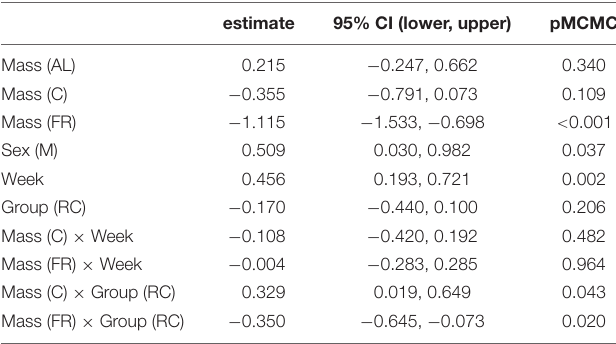
TABLE 1 | The trivariate mixed-effects model showed that the experimental food restriction strongly affected the birds’ body mass. estimate 95% CI (lower,